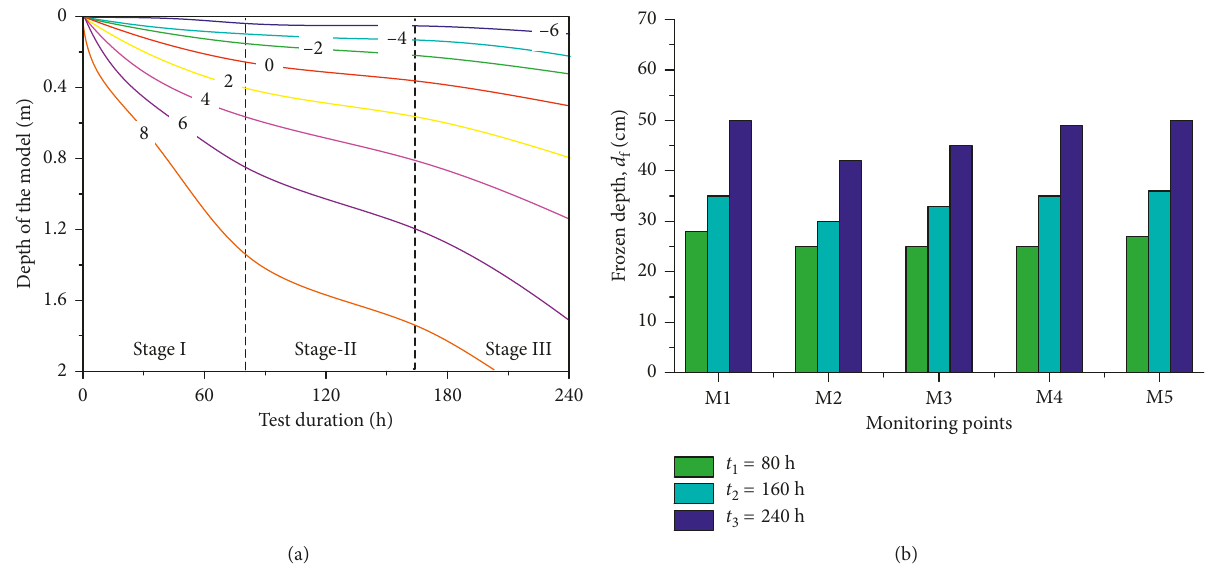
Figure 5: Thermal regime of the irrigation canal. (a) Time history for soils in the canal bank. (b) Frozen depth beneath the canal lining.